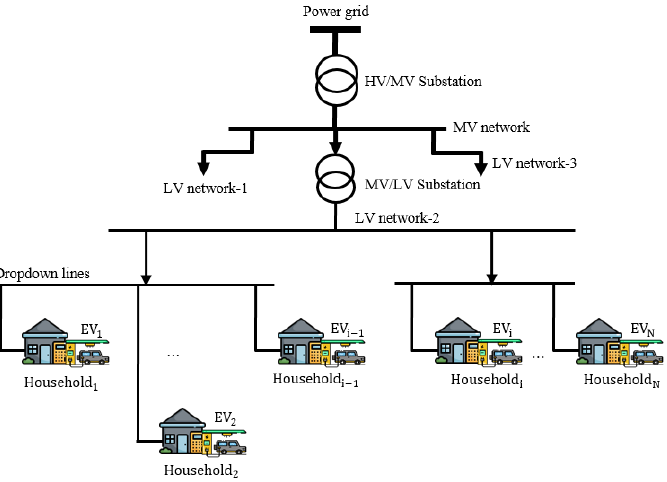
Figure 9. Low voltage distribution network with aggregated households and EV loads.